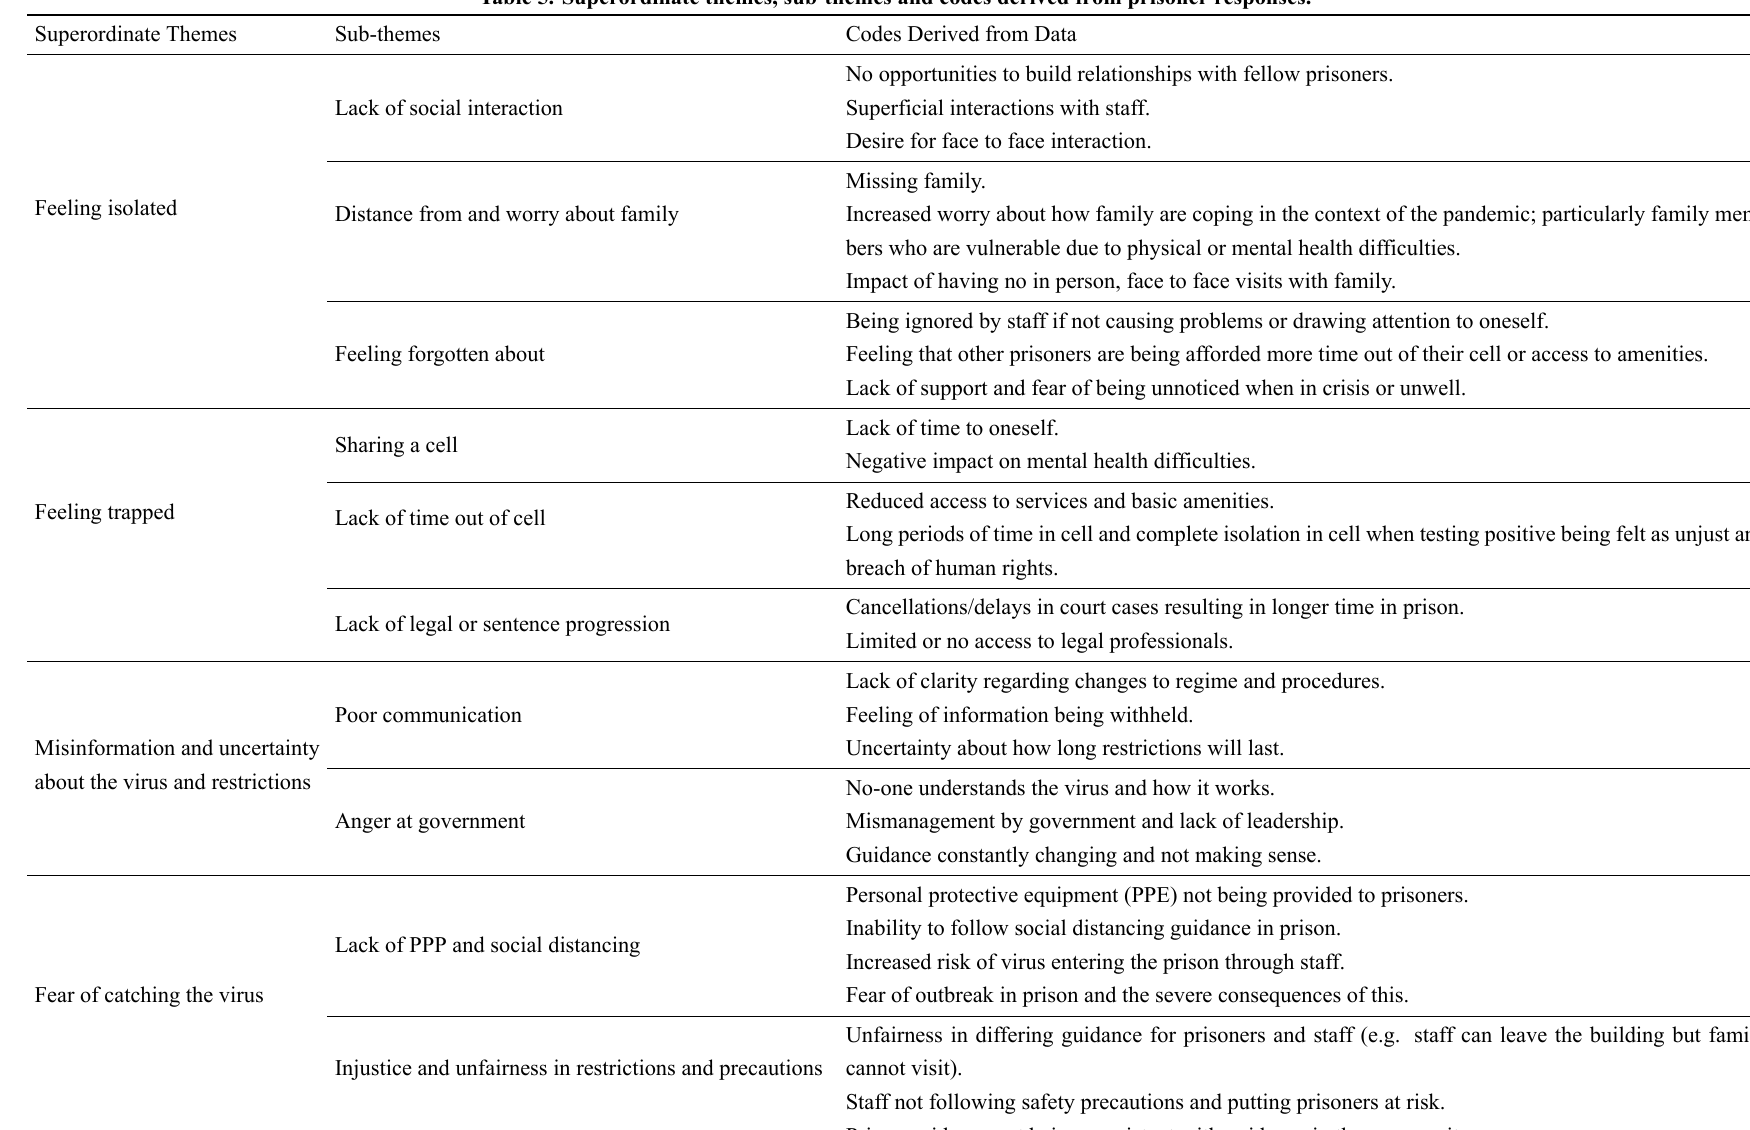
Table 5. Superordinate themes, sub-themes and codes derived from prisoner